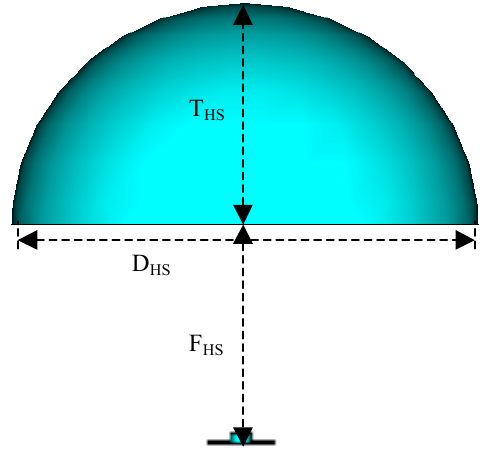
Figure 10: Geometry of a single DRA loaded with upper half dielectric sphere.